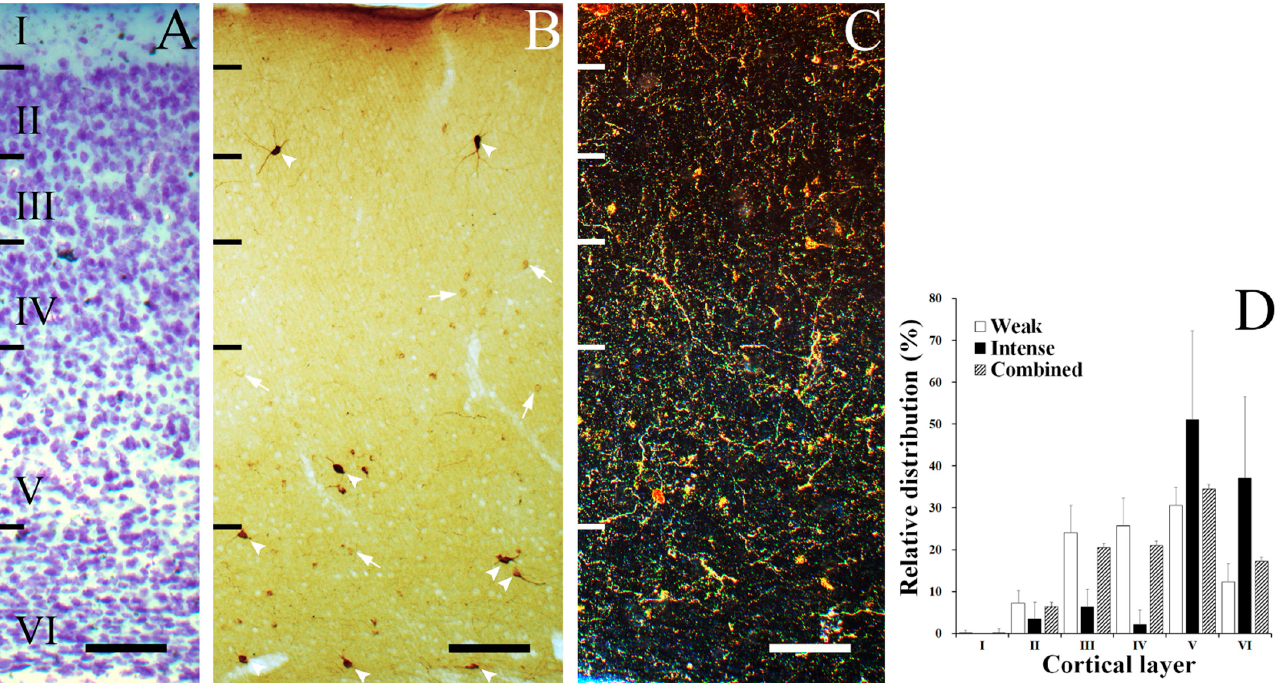
Figure 1. Laminar distribution of SST neurons in the gerbil VC. ( A ) Thionin-stained section illustrating the layer division in gerbil VC. ( B ) Immunostained section showing distribution of SST neurons in gerbil VC. SST neurons in gerbil VC can be distinguished as either intensely (arrowheads) or weakly (arrows) stained, based on their intensity of staining. ( C ) Low-magnification dark field photomicrograph of the gerbil VC with SST fibers dispersed throughout whole layers. ( D ) Histogram of the relative distribution of intensely and weakly stained SST neurons in the gerbil VC. The error bars represent standard deviation (S.D.). Scale bar = 100 μ m.